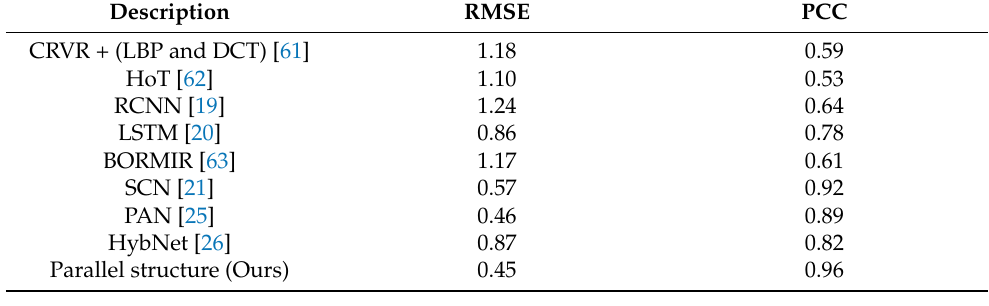
Table 4. Comparison of the proposed approach with other state-of-the-art methods. Description